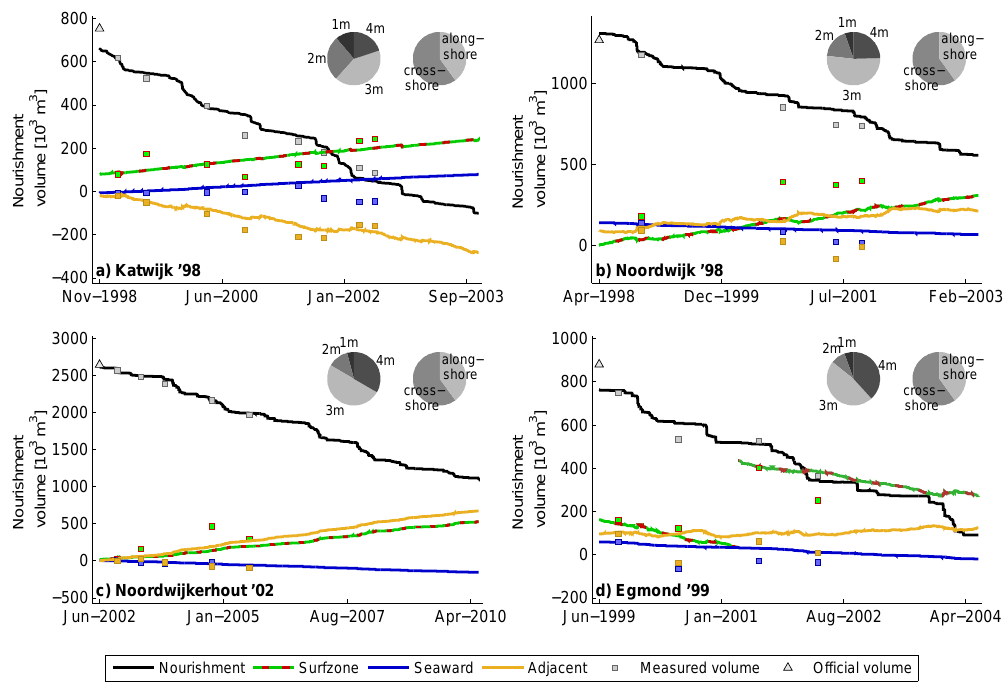
Figure 15. Modelled and observed volumetric change of the Katwijk’98, Noordwijk’98, Noordwijkerhout’02 and Egmond’99 shoreface nourishments. Four different regions are shown: (1) the initial nourishment area, (2) inner surfzone, (3) seaward of the nourishment and (4) the adjacent coast. Observations are shown with square markers. The relative contribution of wave height, wave incidence angle and cross-shore/alongshore erosion of the shoreface nourishment are shown in pie charts. Left pie chart: contribution of wave height classes. Right pie chart: contribution of cross-shore and alongshore transport to the total erosion of the nourishment.